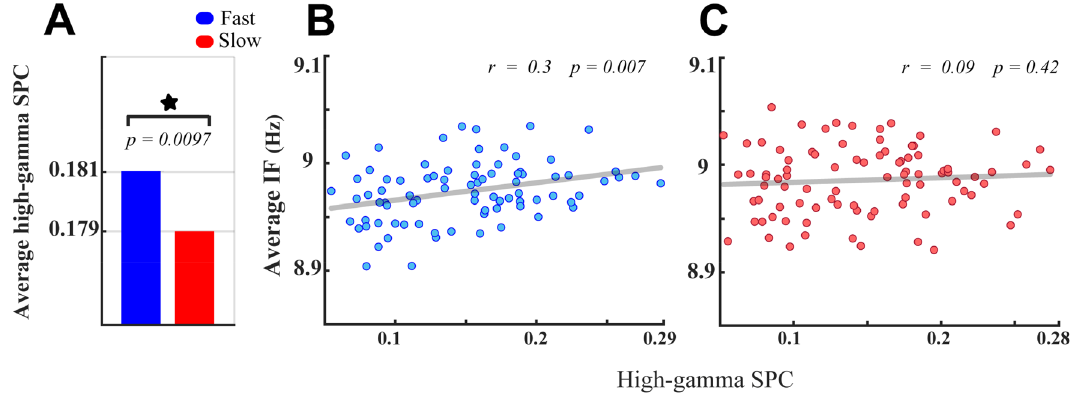
Figure 9. Correlation of neural synchronization in high-gamma (190–210 Hz) with the average theta–alpha IF. ( A ) High-gamma SPC averages of neurons in fast and slow RT trials. The asterisk demonstrates a significant SPC difference in the two types of trials ( p < 0.01, two-sided sign-test). ( B , C ) The average theta–alpha IF (Y-axis) plotted against the high-gamma SPC (X-axis) at individual recording sites (represented by a blue \ red filled circle) using its fast ( C ) and slow ( D ) RT trials. The inset numbers in ( B , C ) reveal the result of conducting a Spearman correlation test on X–Y